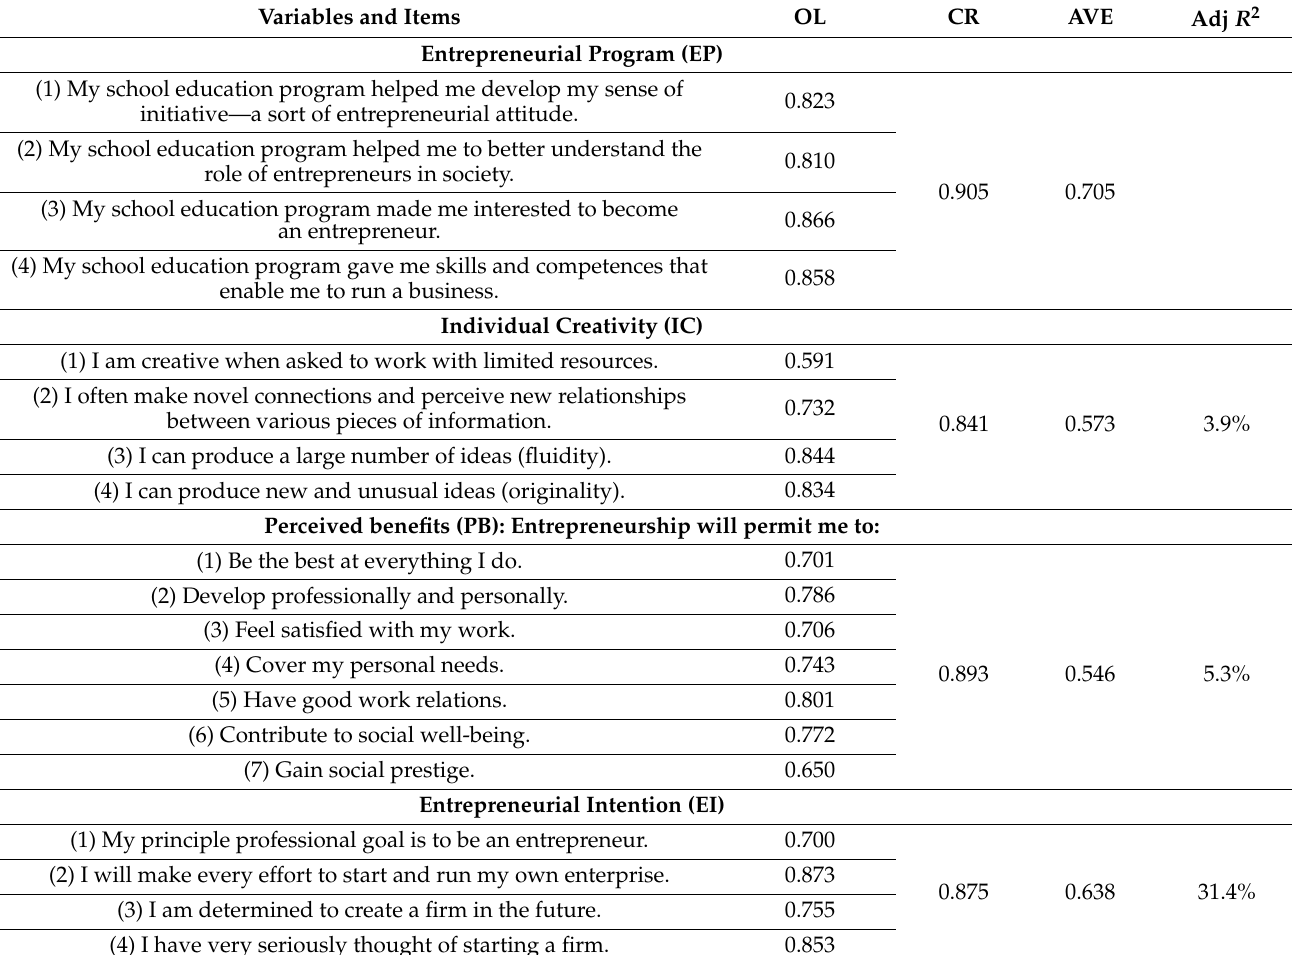
Table 2. Outer Loadings, Composite Reliability, and Average Variance